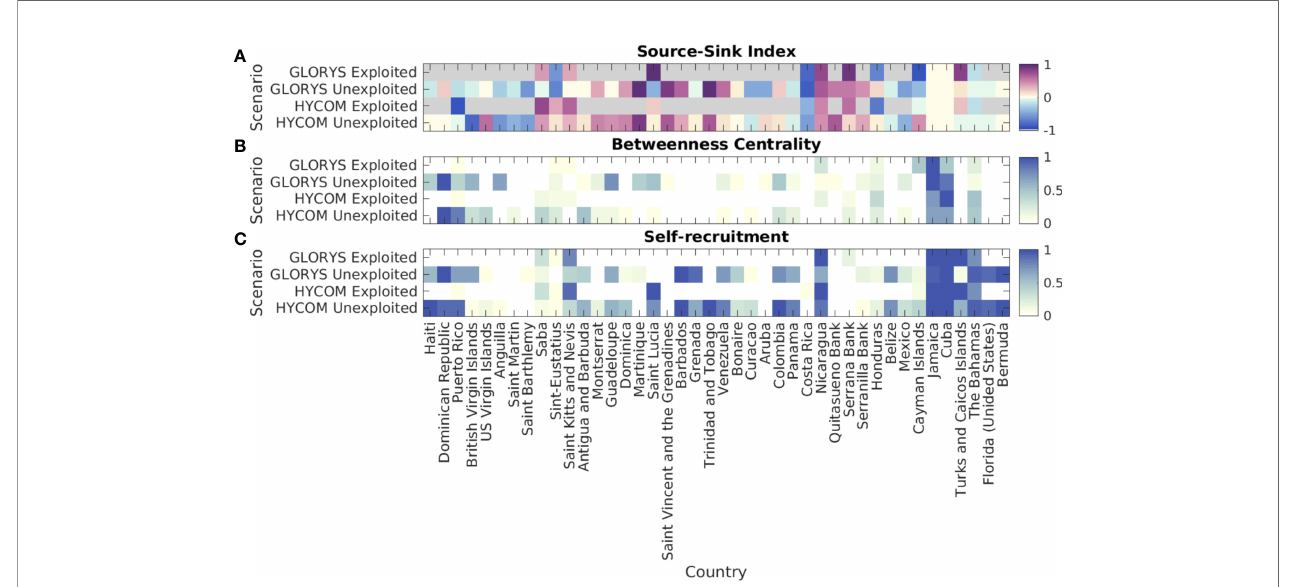
FIGURE 6 | (A) RelativeSource-Sink(SS)Indexforeachjurisdictioninthequeenconchnetwork.PositivevaluesofSSIndexrepresentrelativesourceareaswhilenegative representrelativesinkareas. (B) Relativebetweennesscentrality(BC)foreachjurisdictioninthequeenconchnetwork.BCmeasuresthefractionofshortestpaths passing through a node (jurisdiction) - higher values represent most central nodes, or ecological corridors. (C) Probability of self-recruitment for each jurisdiction in the queen conch network, de fi ned as the proportion of settlers spawned locally in each jurisdiction (local settlers over all settlers in a given jurisdiction). Simulations considered two different reproductive output scenarios: 1) unexploited, i.e., uniform spawning for all habitat polygons; and 2) exploited, with spawning scaled by median adult densities reported per jurisdiction. Larvae dispersed with the HYCOM and the GLORYS12v1 velocities. When considering exploited density of adults, areas with no spawning are colored gray on a). Each node represents all polygons from individual jurisdictions, organized in a clockwise direction from Haiti towards Bermuda. Each model ’ s results are based on 90 releases in the period of fi ve years